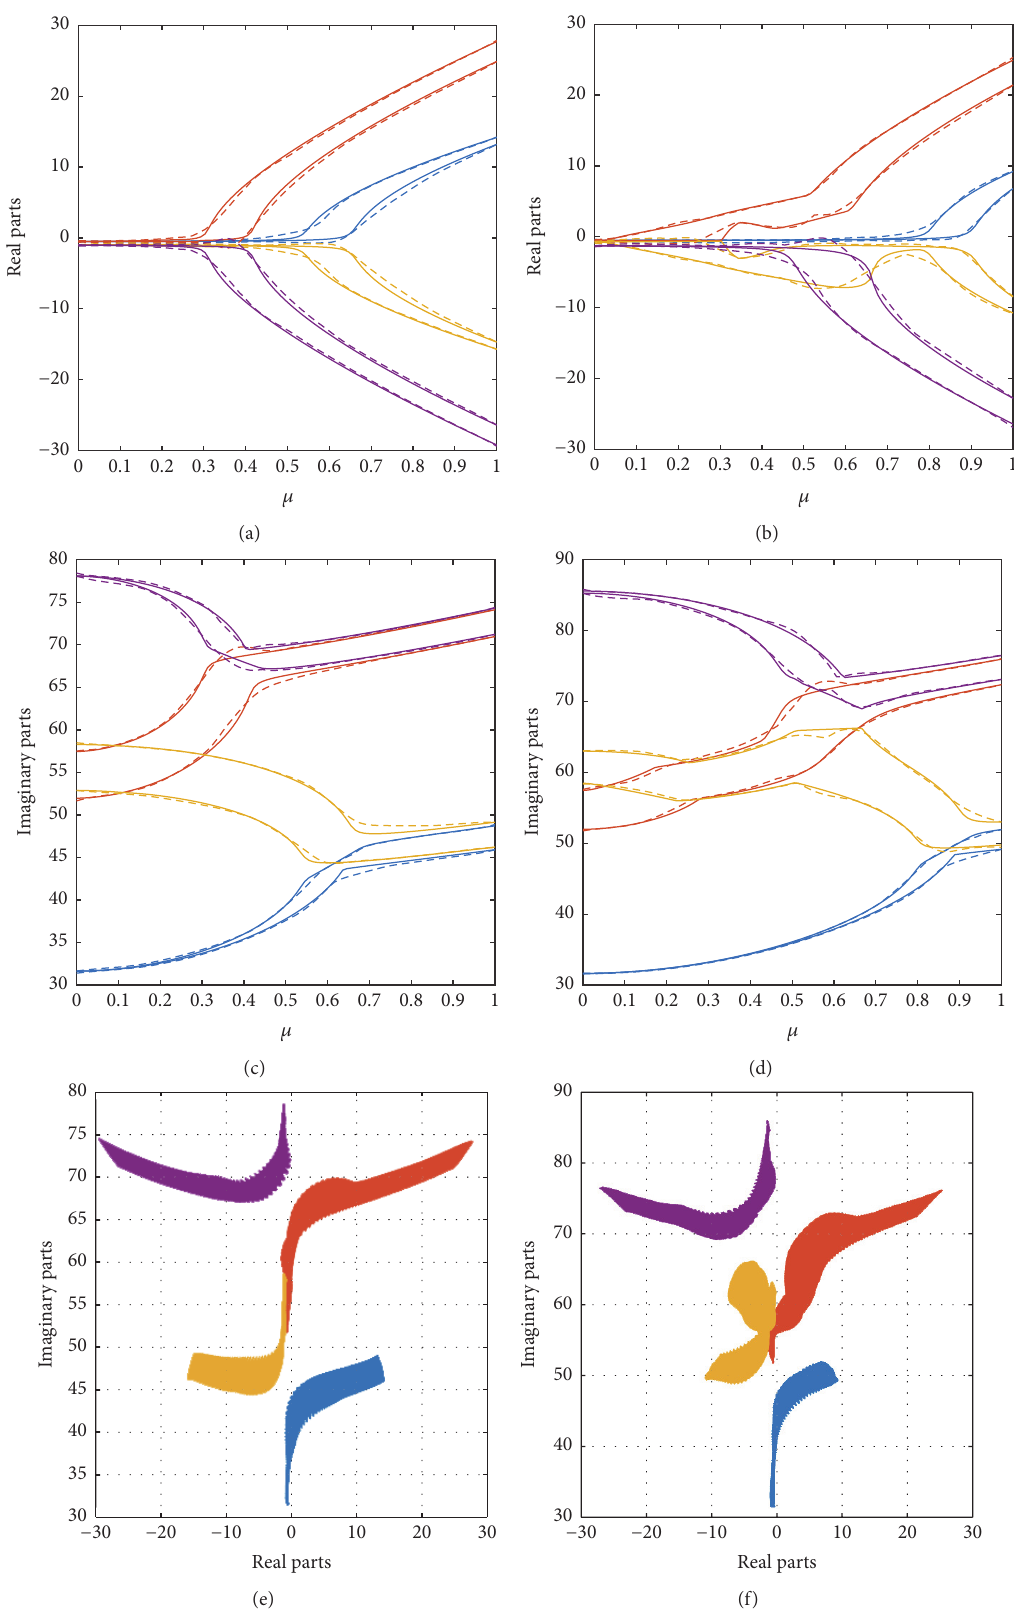
Figure 11: Kriging (--) on three-dimensional parameter space with a 200 points’ LHS experimental design compared to deterministic results ( − ): real (a, b) and imaginary (c, d) parts of eigenvalues versus 𝜇 for configurations 1 (a, c) and 2 (b, d). Evolution in the complex plan based on kriging metamodel for configurations 1 (e) and 2